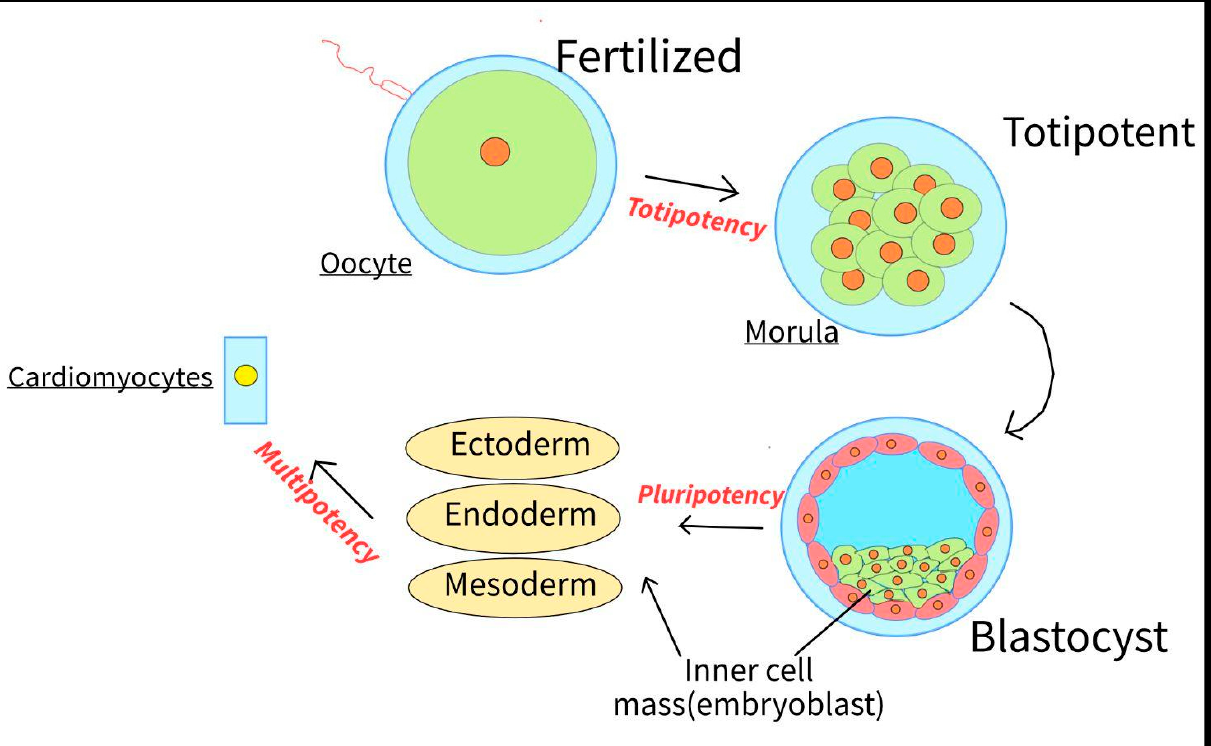
Figure 3. Diagram showcasing the steps from a fertilized egg to a cardiomyocyte; totipotency, pluripotency, and multipotency achieved through the process for embryonic stem cells. Cardiomyocytes are part of the group of cells that can be differentiated from iPSCs.